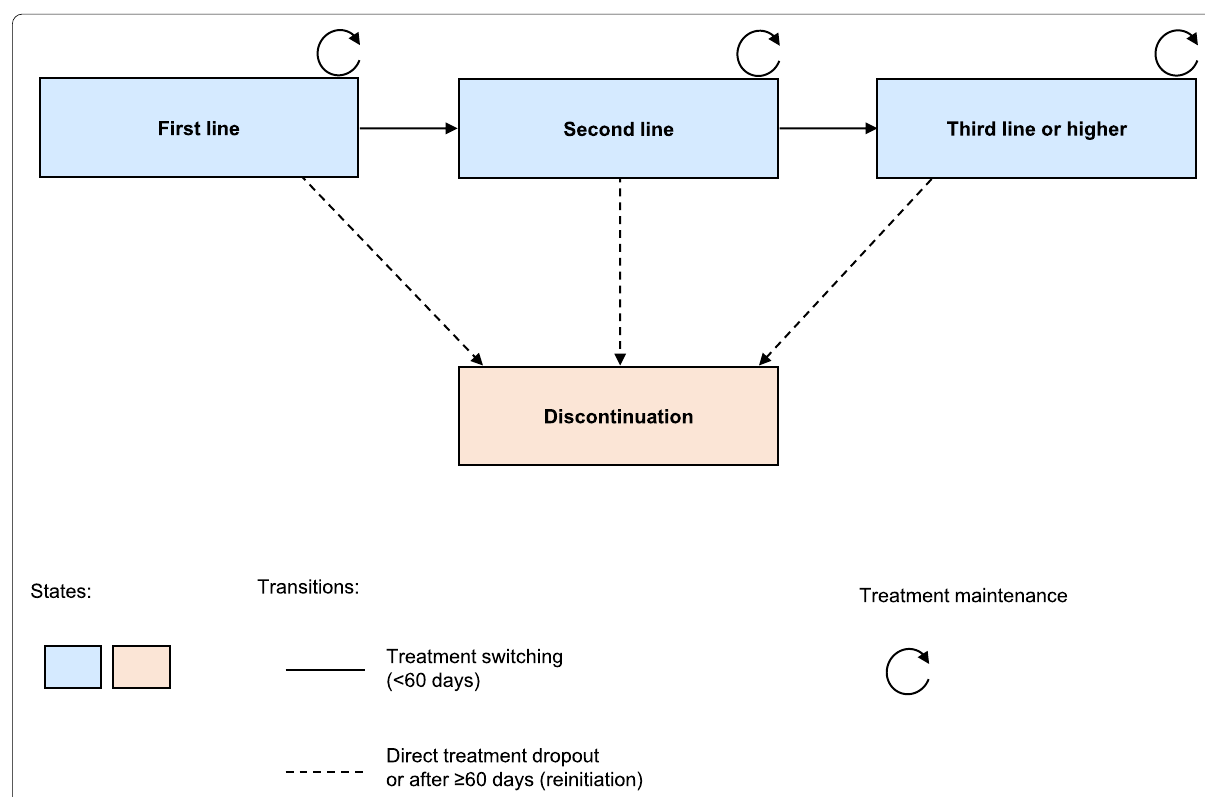
Fig. 1 Multi‑state model design of the migraine preventive therapy. To create the model, it was assumed that patients in any line of treatment could maintain it, discontinue it or switch medications, which generated four possible states and five different transitions. Treatment switching was defined by any change of medication within 60 days from the last prescription, while treatment discontinuation may have been due to reinitiation after 60 days or more without renovating it or direct mediation